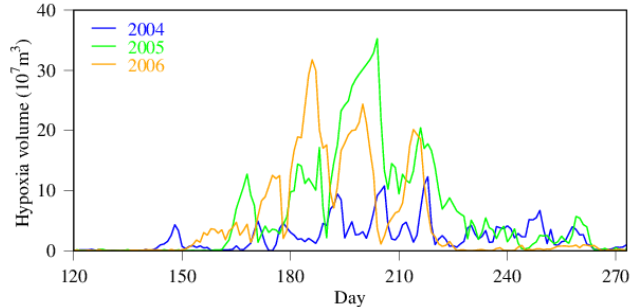
Figure 6. Time ‐ series of hypoxia volume in 2004 (low hypoxia year) and 2005 and 2006 (high hypoxia years).